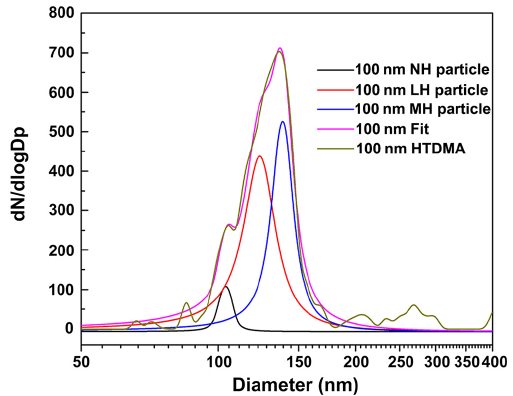
Figure 3. HTDMA and peak fitting reconstruction for 100nm at- mospheric particles at 84% RH on 28 September 2021.